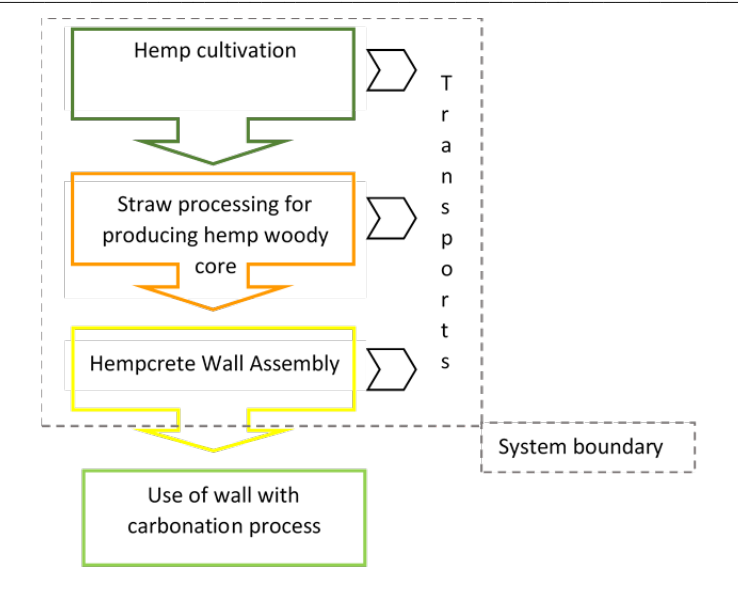
Fig. 1. System boundaries of 1 m 2 of hempcrete wall